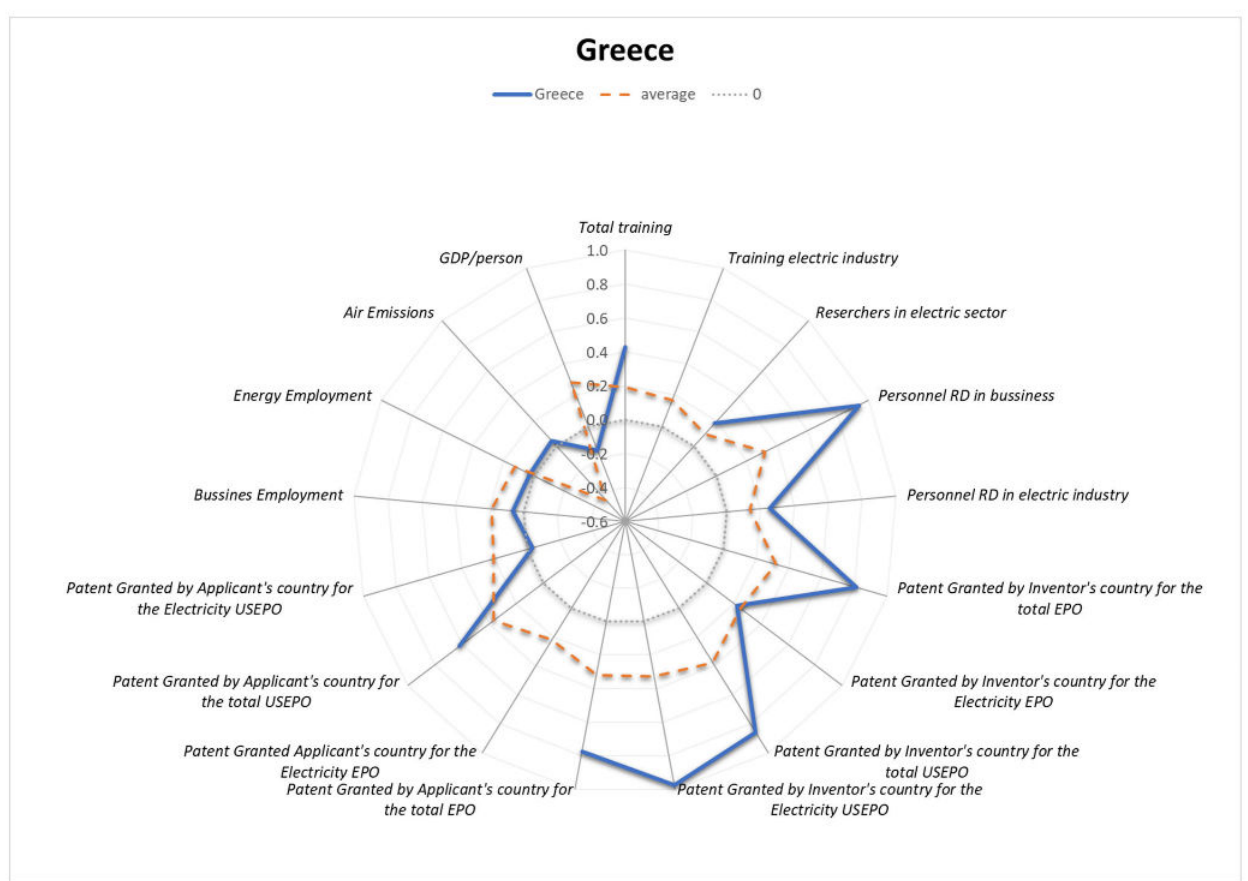
Figure 19. Synergy and trade-off occurrence—EL. Source: Authors’